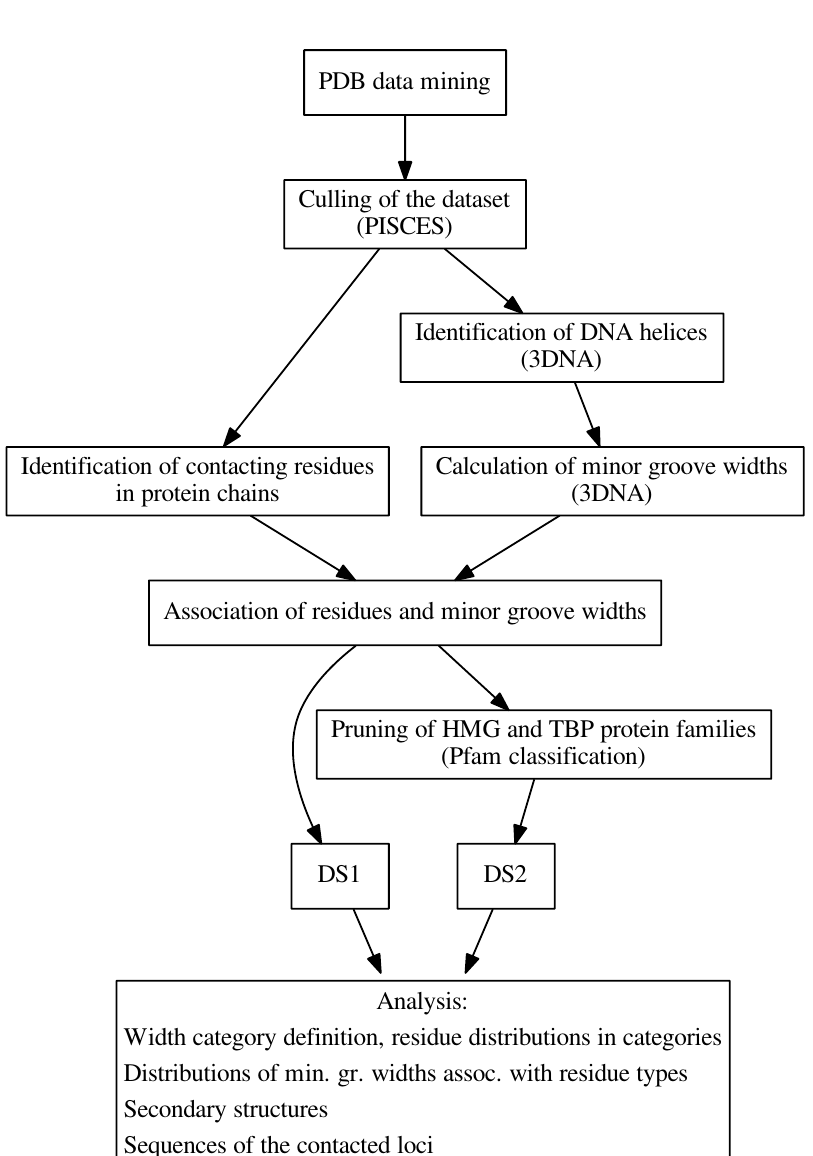
Figure 1. An overview of the workflow and analyses performed in this work. Individual steps are described in detail in Section